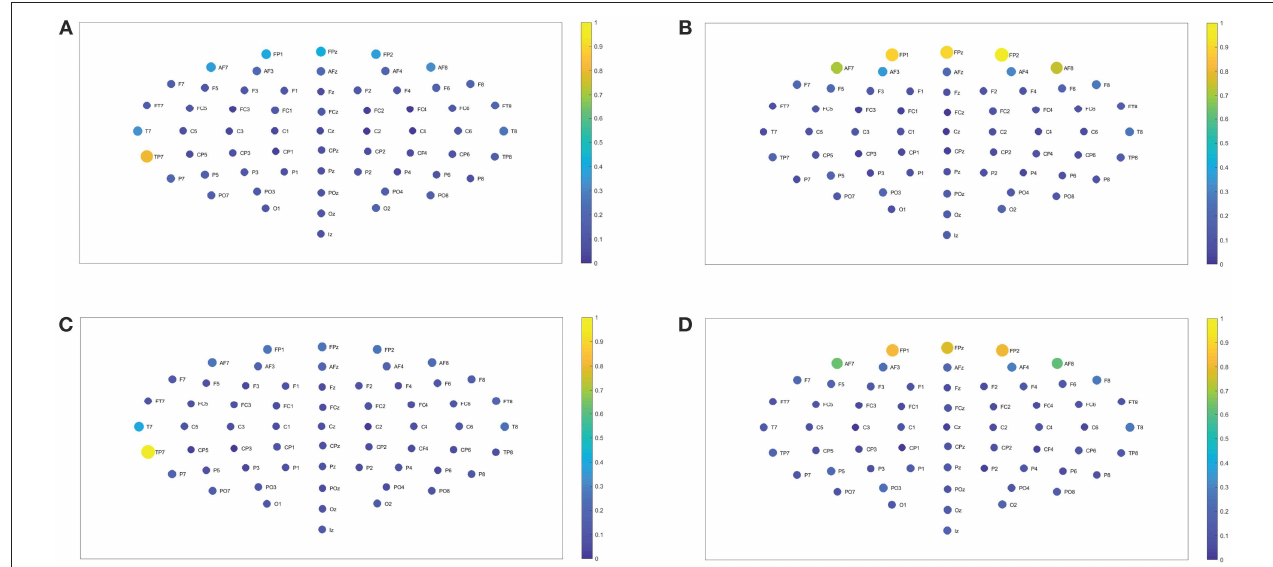
FIGURE 7 | Closeness centrality. (A,B) Show the nodes’ closeness centrality considering 109 subjects when performing the visuomotor task for the 62-channels EEG considering the different oscillation bands delta and theta. (C,D) Are the same as (A,B) but considering the imagined task. We consider D = 6 and τ = 1. Delta oscillation band corresponds to [1,4) Hz and theta oscillation band to [4,8) Hz .